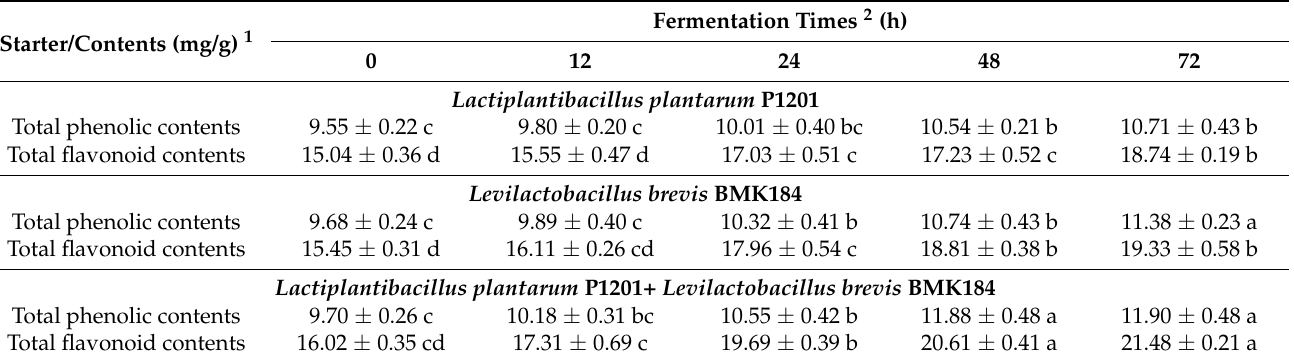
Table 3. Changes of total phenolic (TP) and total flavonoid (TF) contents during the fermentation of isoflavone-enriched soybean leaves (IESLs) with the use of Lactiplantibacillus plantarum P1201 and/or Levilactobacillus brevis BMK184 as